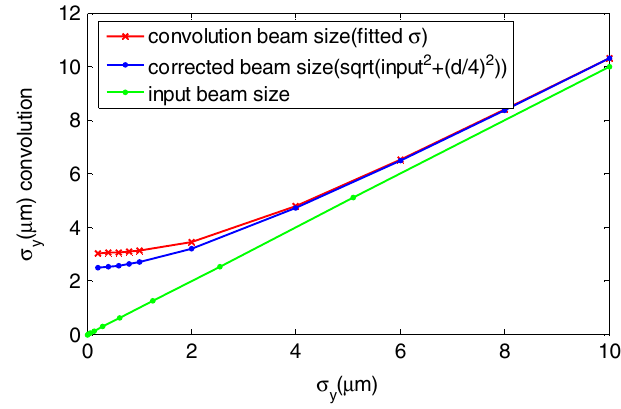
FIG. 2. Effect of folding a 10 (cid:2) m diameter cylindrical wire with a Gaussian beam distribution as a function of its root mean